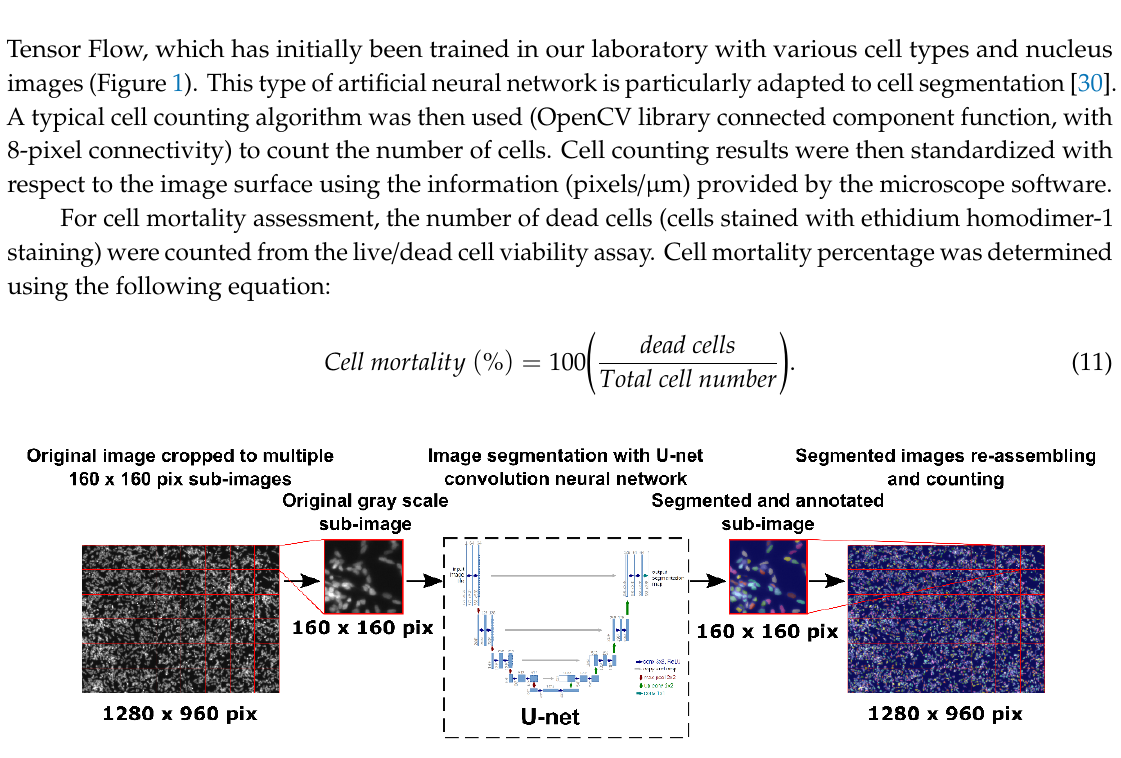
Figure 1. Schematic of the segmentation and counting of cell or nucleus using a U-net convolution neural network.